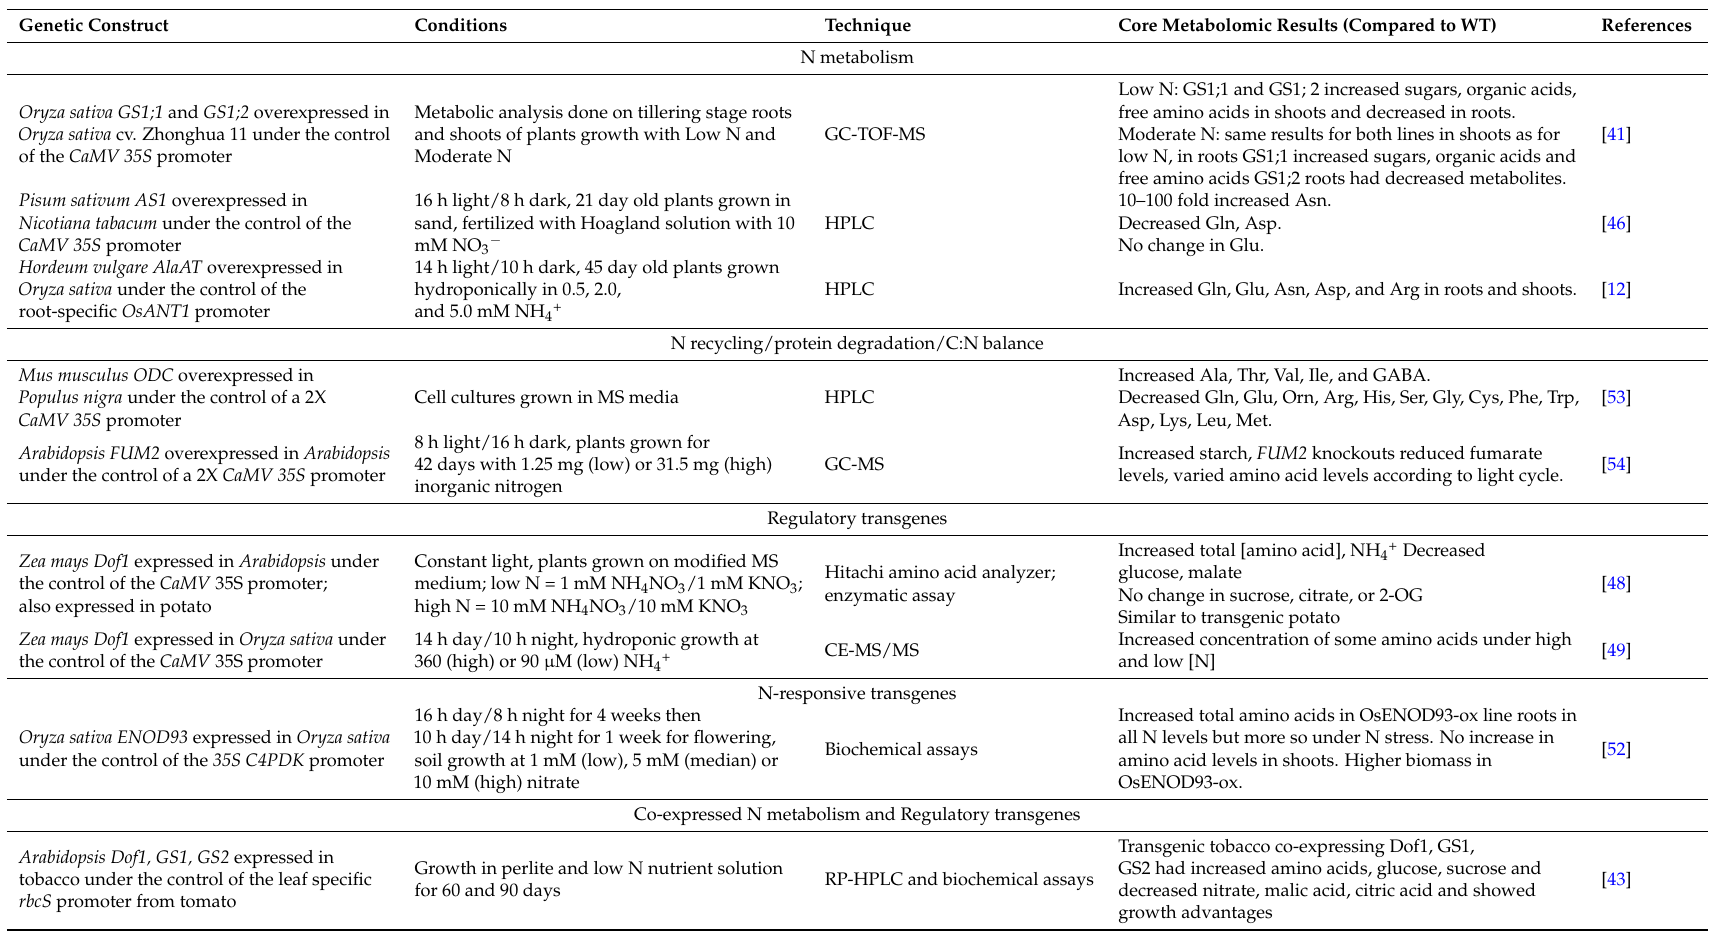
Table 2. Effect of transgene expression on metabolite levels in transgenic